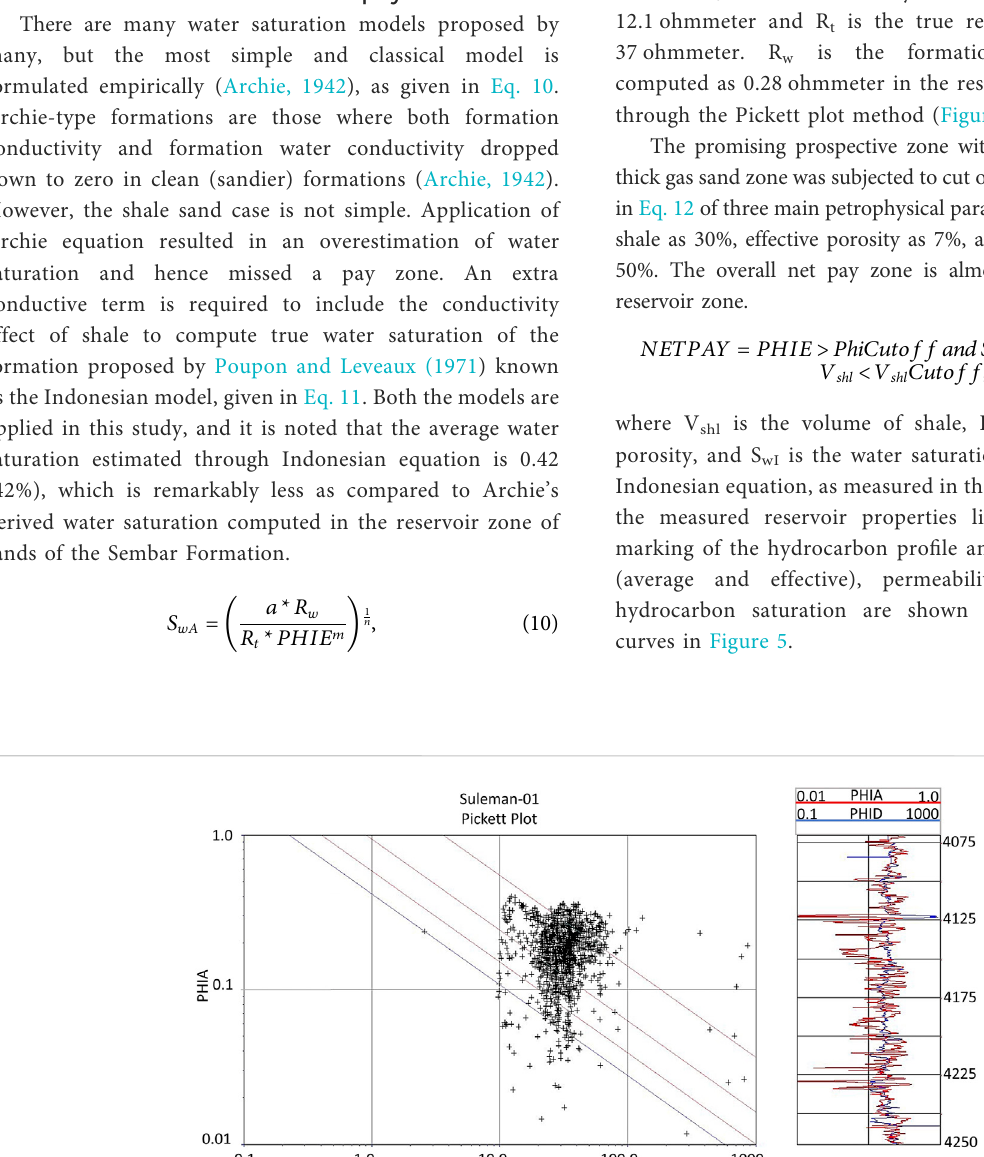
Frontiers in Earth